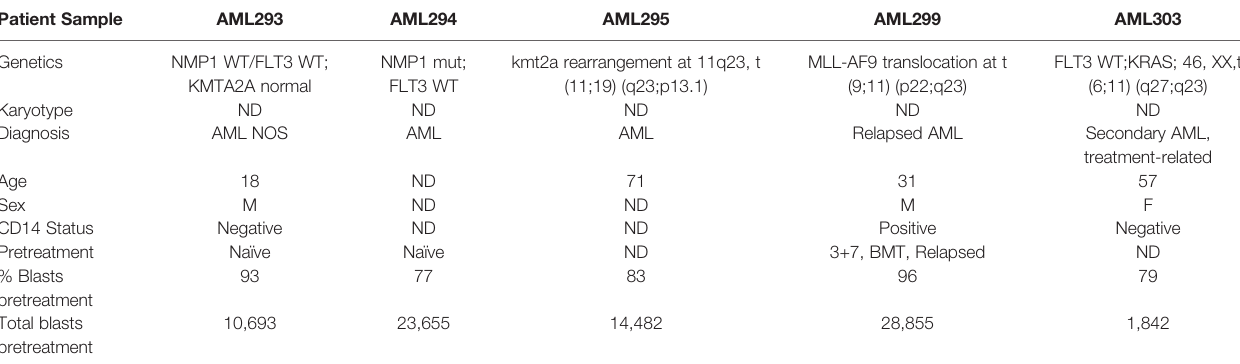
TABLE 1B | Patient sample